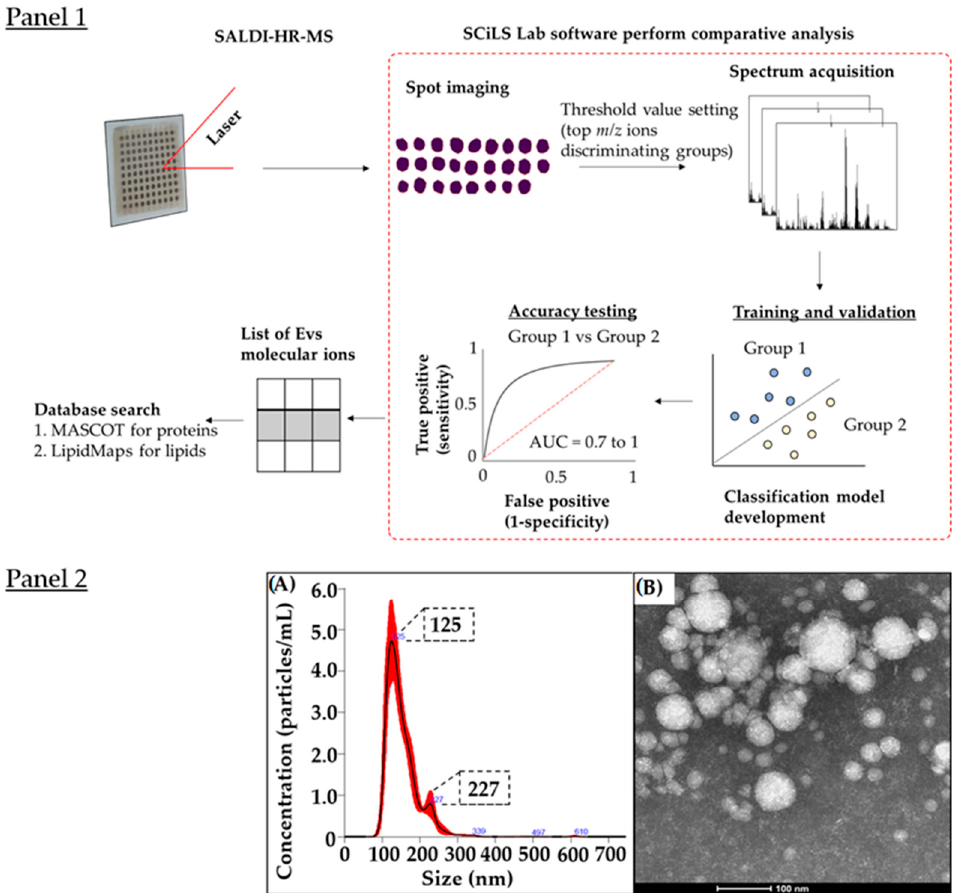
Figure 1. ( Panel 1 ) illustrates the workflow and statistical analysis to discover the top discriminative spectral ions from CRC, CLM and CFI groups. Firstly, each sample’s spots were selected, then threshold values for the top 50 m / z spectral ions were assigned. Secondly, the linear discriminant analysis algorithm model classifies different sample groups (for example, CRC vs. CFI). The algorithm selected m / z spectral values ranging between AUC 0.7 to 1. Lastly, a list of top spectral ions peaks that discriminate sample groups were acquired. These ions were then uploaded into databases including MASCOT and LipidMaps to identify putative proteins and lipids. ( Panel 2 ) shows size of EVs isolated from CRC plasma samples. ( A ) NTA method identified that the EVs concentration was 3.27 × 10 8 ± 1.53 × 10 7 particles/mL with the size of Mean: 152.0 ± 1.1 nm, Mode: 125.7 ± 5.8 nm, SD: 43.1 ± 2.1 nm in size. ( B ) Negative staining TEM that plasma-derived EVs ranged between 40 to 120 nm size with spheroid shape. CRC—Colorectal cancer stage-I to stage-IV; CLM—Colorectal cancer liver metastasis; CFI – Cancer free individual; NTA—Nanoparticle tracking analysis; TEM— Transmission electron microscopy; EVs—Small extracellular vesicles.